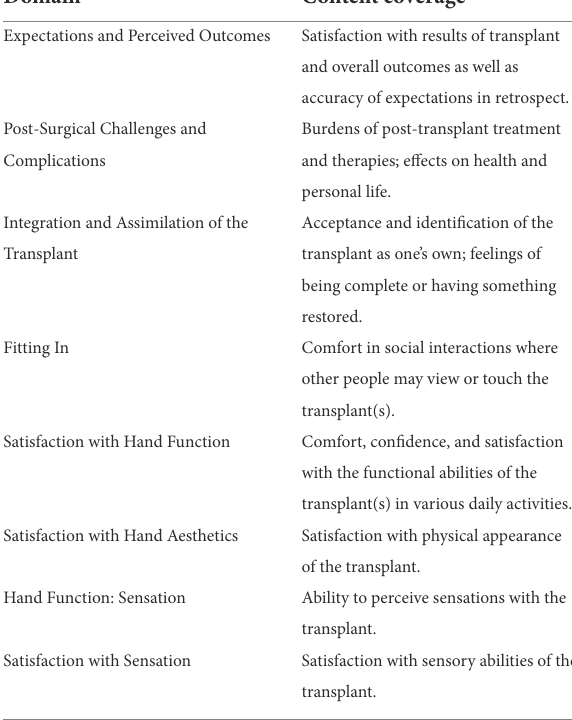
TABLE 1 New domains to evaluate HRQOL after UE